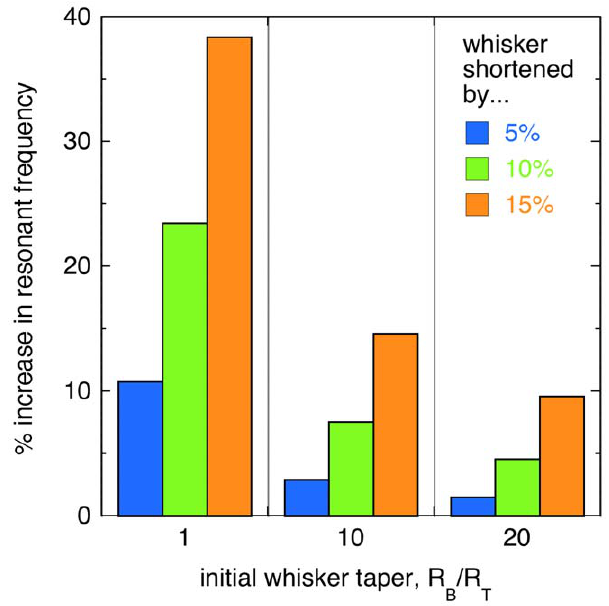
Figure 5. Resonant frequency robustness . Graph showing the percentage increase in the resonant frequency of a model whisker after a break that decreases the length by 5, 10, or 15%. Values are calculated using Eqns. (1) and (2), for an untapered elastic beam ( R B / R T =1) or a tapered elastic beam ( R B / R T =10 and 20).